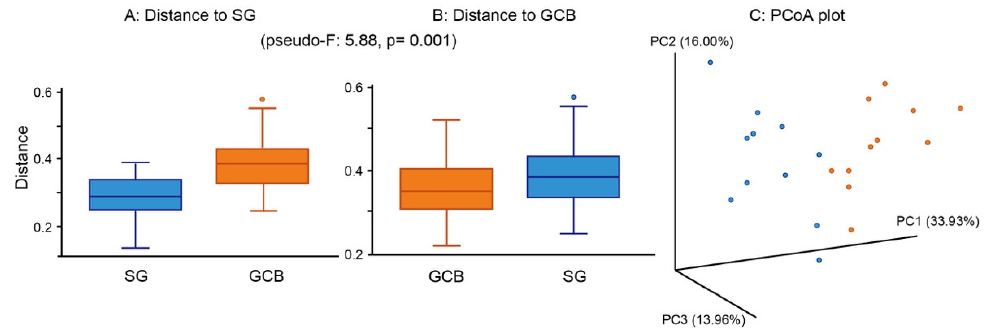
Figure 5. β -diversity of root caries lesions. Distance boxplot ( A , B ) and PCoA plot-weighted unifrac ( C ). The analysis shows the significantly distinguished clustering between SG and GCB. Statistical result appears in the figure. SG: root caries that existed independently above the gingival margin, GCB: root caries that progressed below the gingival margin. Lefse revealed the bacterial characteristics of each group at the genus level (Figure 6).